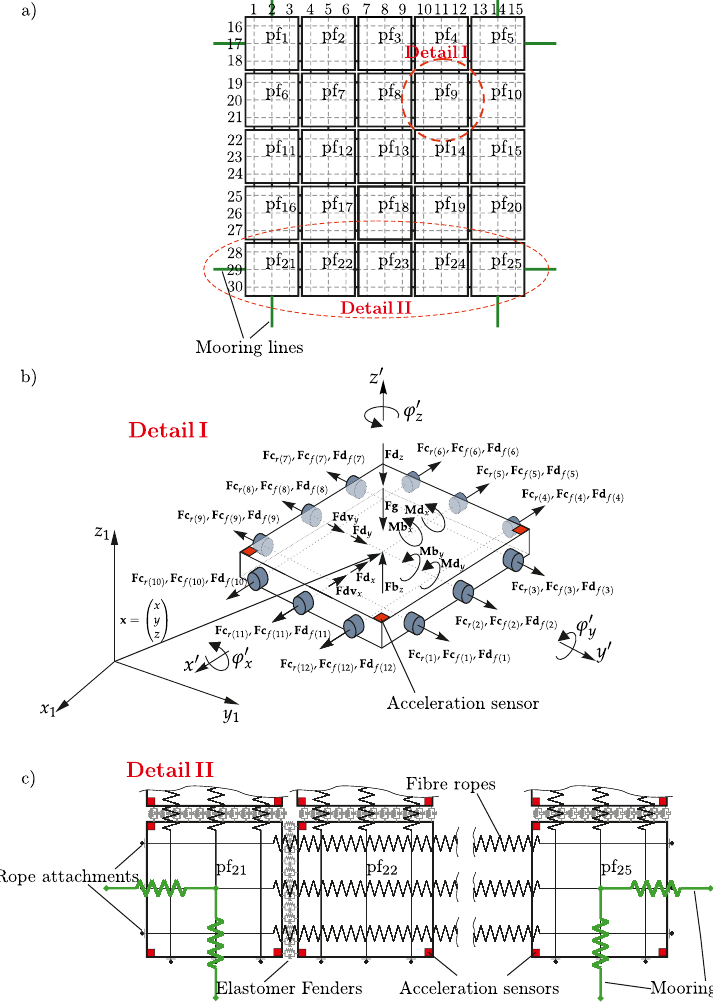
Figure 2. ( a ) Platform arrangement of 25 platforms and 30 ropes. ( b ) Forces and moments acting on a single platform. ( c ) Detailed schematic representation of several platform connections ( c ).